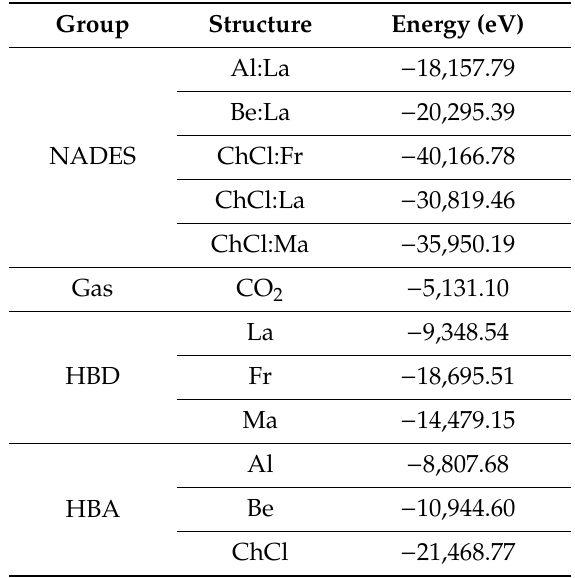
Table 3. Summary of energies of optimized structures.